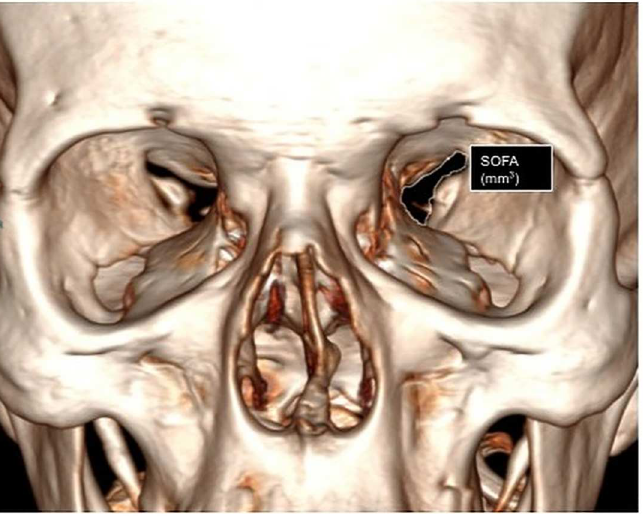
Fig 1. 3D CT reconstruction. Measurements of the superior orbital fissure area obtained using curve measurement